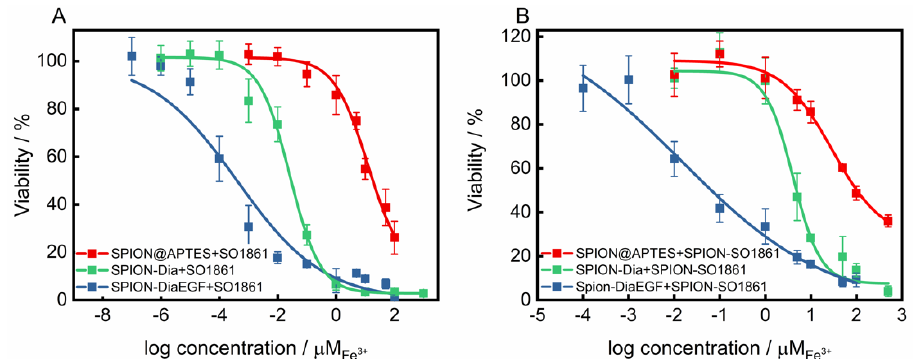
Figure 7. Cytotoxicity studies of SPIONs after each functionalization step on EGFR-overexpressing HCT-116 cells ( A ) applied in a combinatorial approach with 0.5 μg/mL free SO1861 and ( B ) with SPION-SO1861, respectively. Cell viability was assessed after 48 h by MTT-assay and plotted as a function of the molar iron concentration. Each point represents the mean ± SD of at least 3 independent experiments, performed in quadruplicate. Corresponding IC50 and EF values are shown in Table 1. Corresponding half maximal inhibitory concentration ( IC 50 ) values and enhancement factor (EF) derived from Figures 6 and 7 of the respective particle based anti-tumor systems. Since the IC 50 was not reached for SPION@APTES and SPION@BCN, specification of the EF was not possible for these particle systems. The targeting effect is defined as the ratio of the IC 50 values of the non-targeted compound (SPION-Dia) to the targeted compound (SPION-DiaEGF). The gain in specificity is the ratio of the targeted EF to the non-targeted EF.